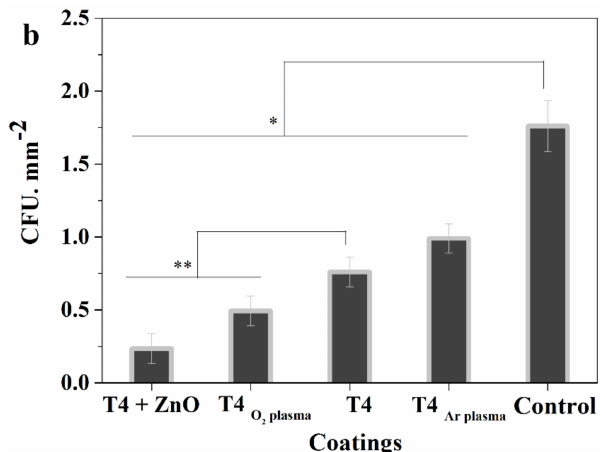
Figure 9. ( a ) photographs of E. coli colonies on agar culture plates after 24 h incubation on various T4 coatings; ( b ) colony forming units / mm 2 on modified T4 surfaces and the control. All T4 surfaces showed a significant reduction in bacterial adhesion w.r.t. control (* p < 0.05). T4 + ZnO and T4 O2 plasma demonstrated a significant reduction in bacterial adhesion w.r.t. to T4 (** p